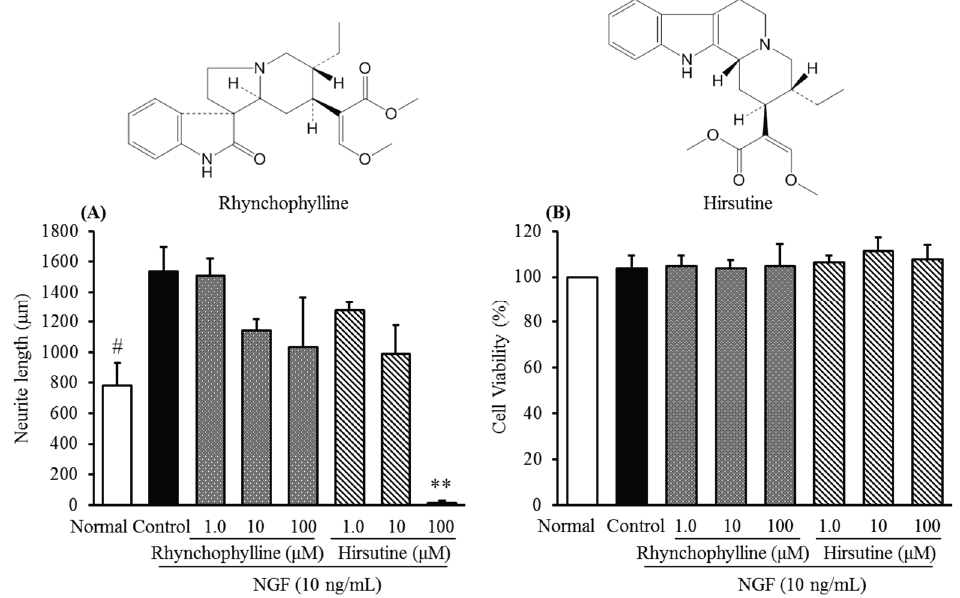
Figure 4. Chemical structures of rhynchophylline and hirsutine and their inhibitory activities against NGF-induced neurite growth ( A ) and cell cytotoxicity in cultured DRG neurons ( B ). Values are the means ± S.E.M. of triplicate experiments. # p < 0.05 vs . Control (Student’s t -test); ** p < 0.01 vs. Control (Dunnett’s